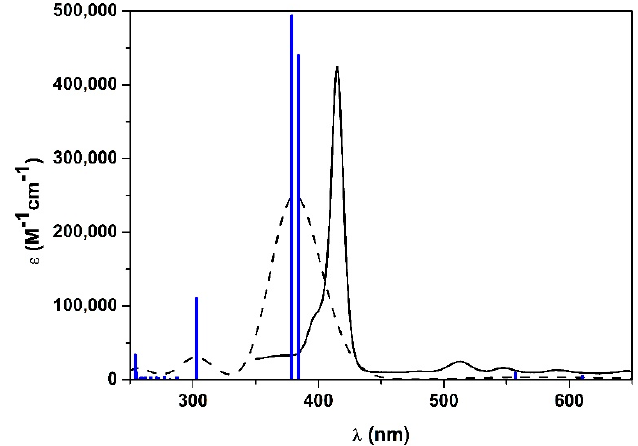
Figure 3. Experimental UV-vis spectrum of 1H 2 in EtOH (black line), calculated spectrum with WB97XD functional and 6-311G(d,p) basis set (black-dashed line) and the corresponding calculated electronic transitions (blue bars).